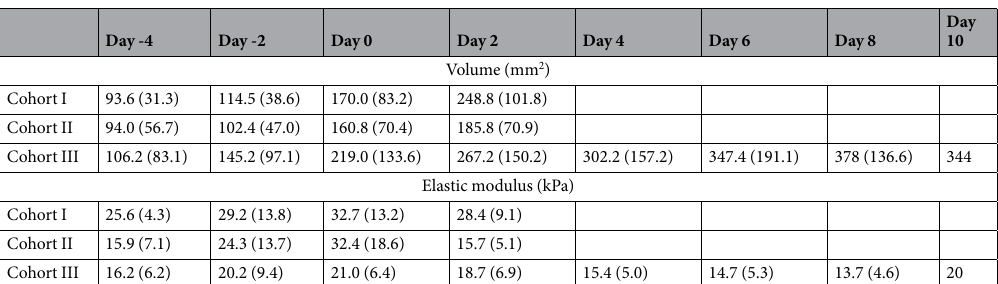
Table 1. Detailed results of volume and elastic modulus measurement for each cohort. Standard deviation values are given in